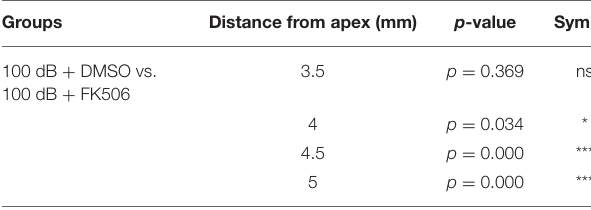
TABLE 1 | Post-hoc analysis of outer hair cell loss ( Figure 2E ).